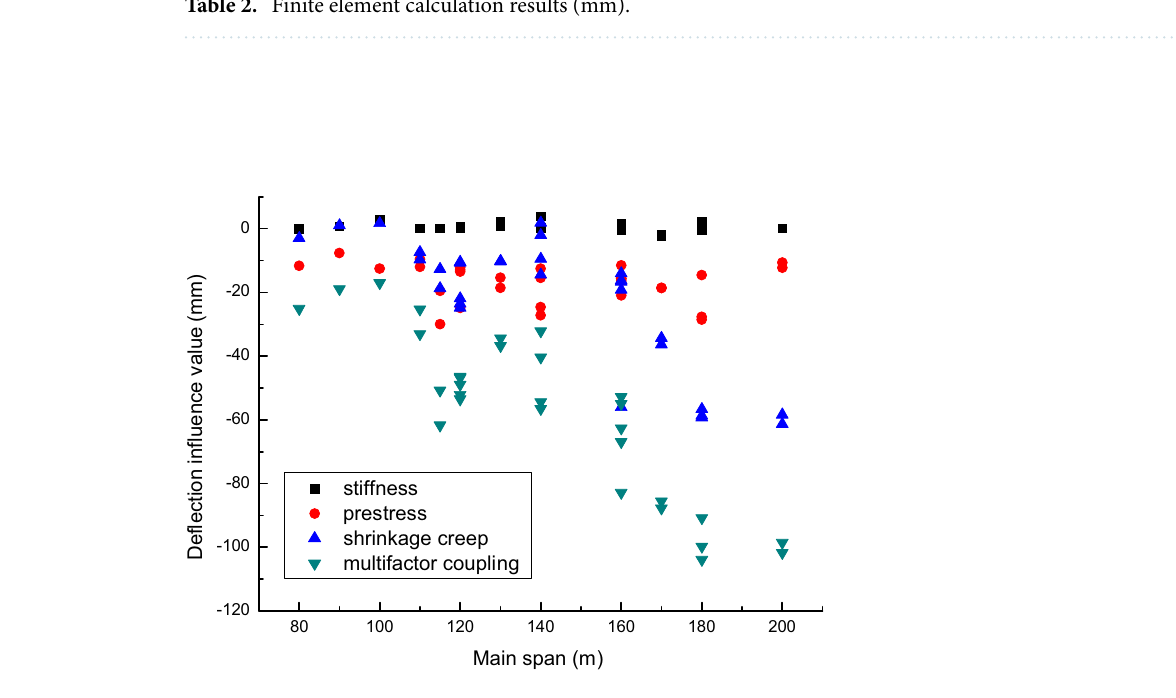
Figure 5. Influence of various factors on mid-span